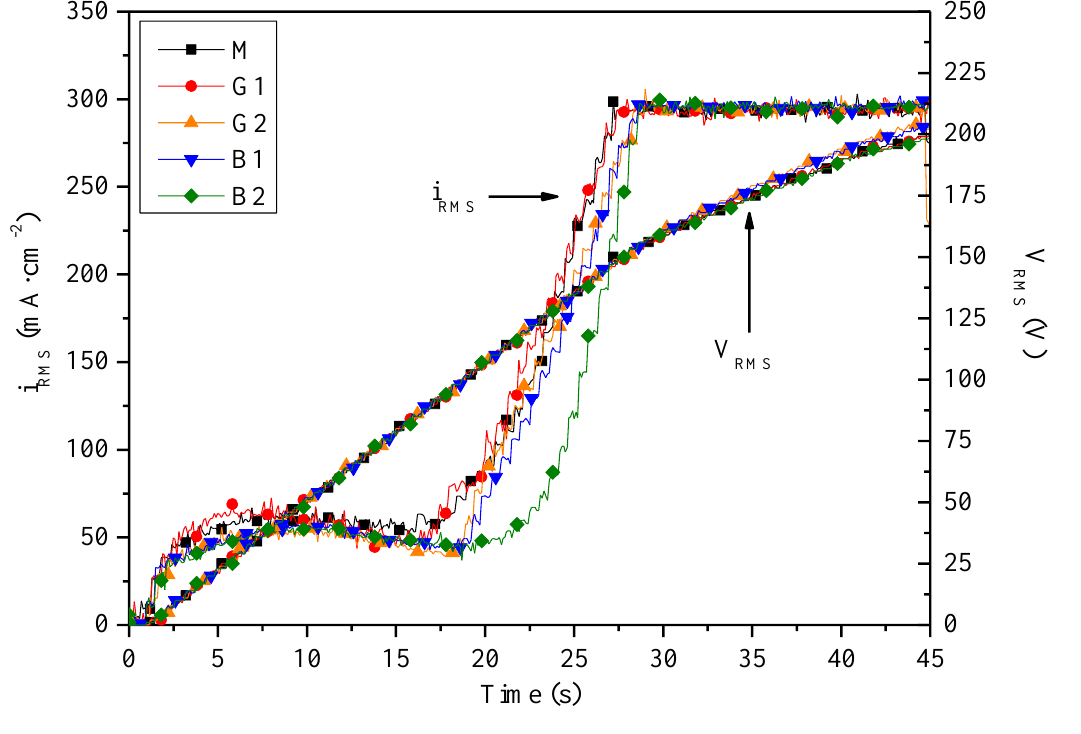
Figure 6. Evolution of the RMS current density and voltage (i RMS and V RMS , respectively) during the PEO treatments.